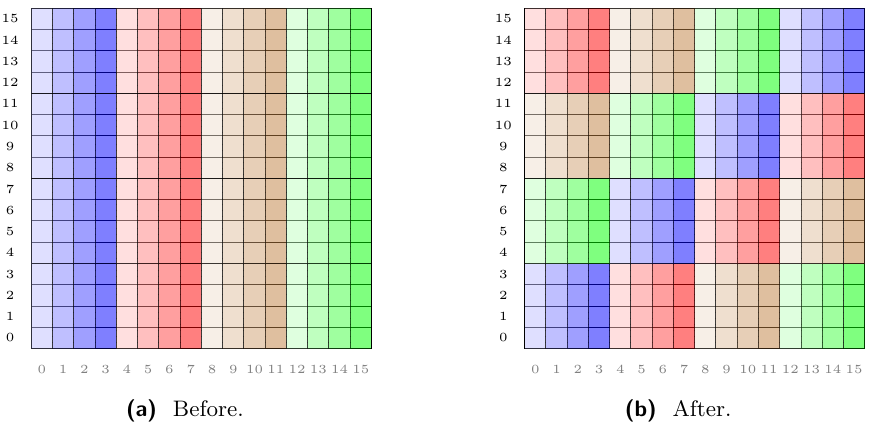
Figure 14: The SR sheet operation that mixes the columns in each sheet